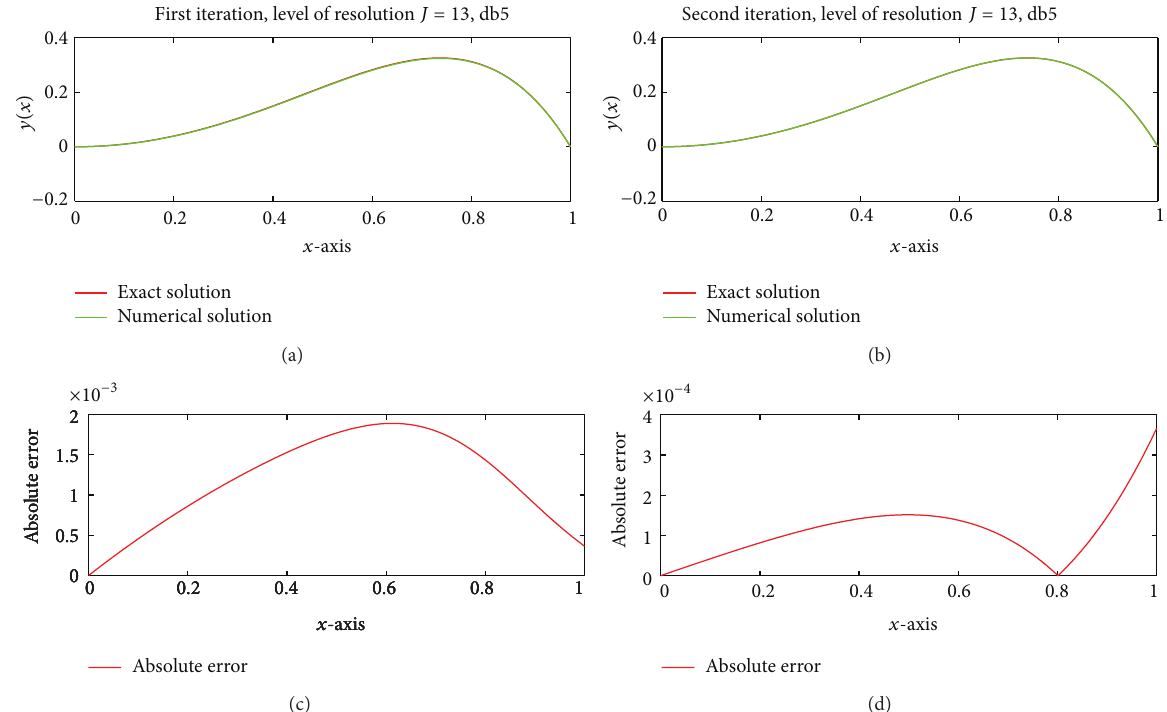
Figure 4: Comparison of exact solution and solution by wavelet-Galerkin method with quasilinearization technique at 𝐽 = 13 , for different iterations, and we use 𝐷10 as Galerkin bases.